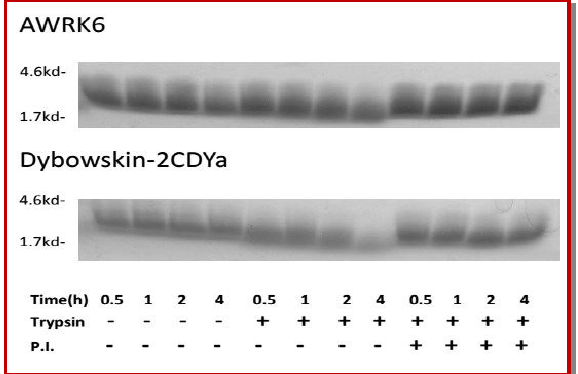
Figure 5: Susceptibility of Dy2 and AWRK6 to proteolysis Each peptide was incubated with trypsin without or with protease inhibitor (cid:871) P.I. (cid:872) in 10 mM Phosphate buffer (pH 7.5) for the indicated